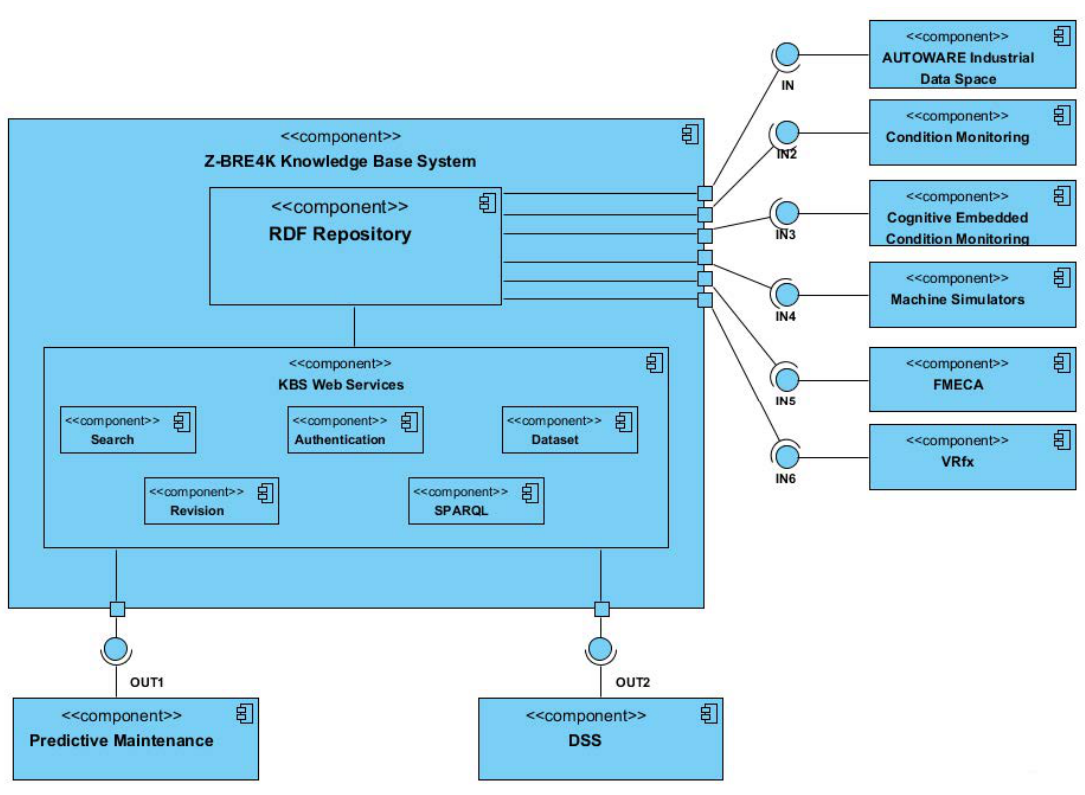
Figure 6. Semantic description of an example scenario.